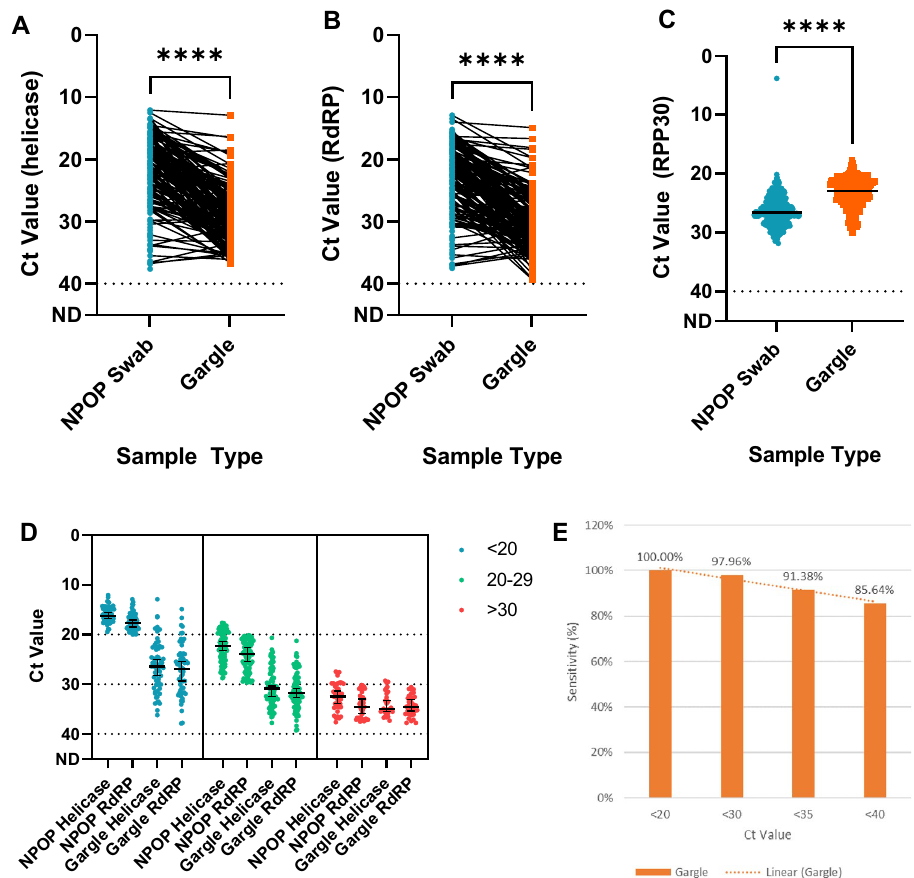
Figure 2. Sensitivity of gargle specimens is comparable to NPOP swabs for the detection of COVID-19. Higher Ct values were observed for the majority of gargle samples on both helicase ( A ) and RdRP ( B ) target genes. ( C ) RPP30’s Ct values were significantly lower in gargle specimens. ( D ) Difference in Ct value distribution when analyzed by NPOP Ct groups (low: < 20; moderate: 20–29; high: > 30). ( E ) However, the lower viral load in gargle specimens does not impact the performance of gargle specimens in detecting COVID-19, as the sensitivity is still 91.38% for Ct <